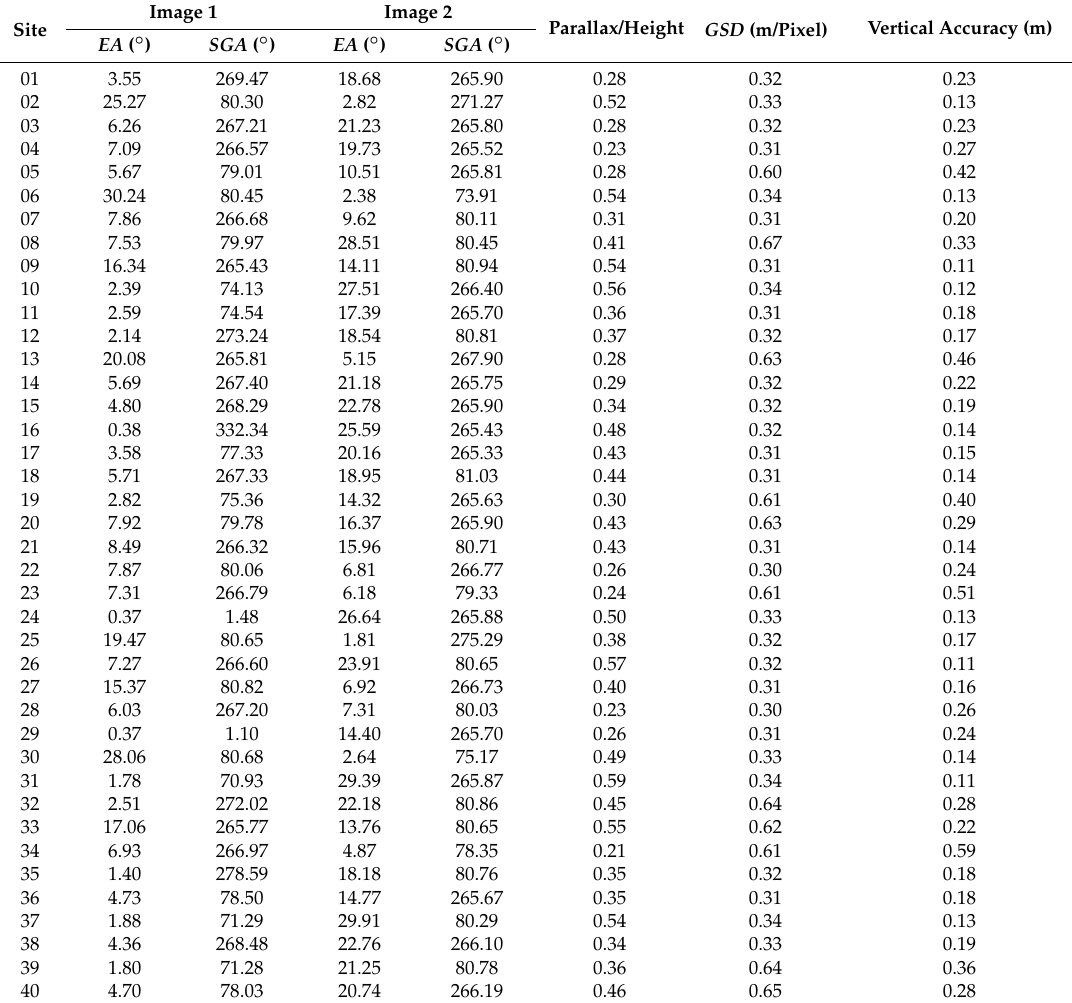
Table 2. Expected vertical accuracy values for each